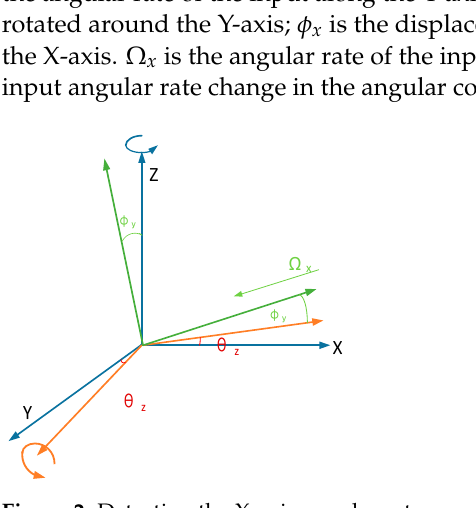
Figure 2. Detection the X-axis angular rate coordinate.